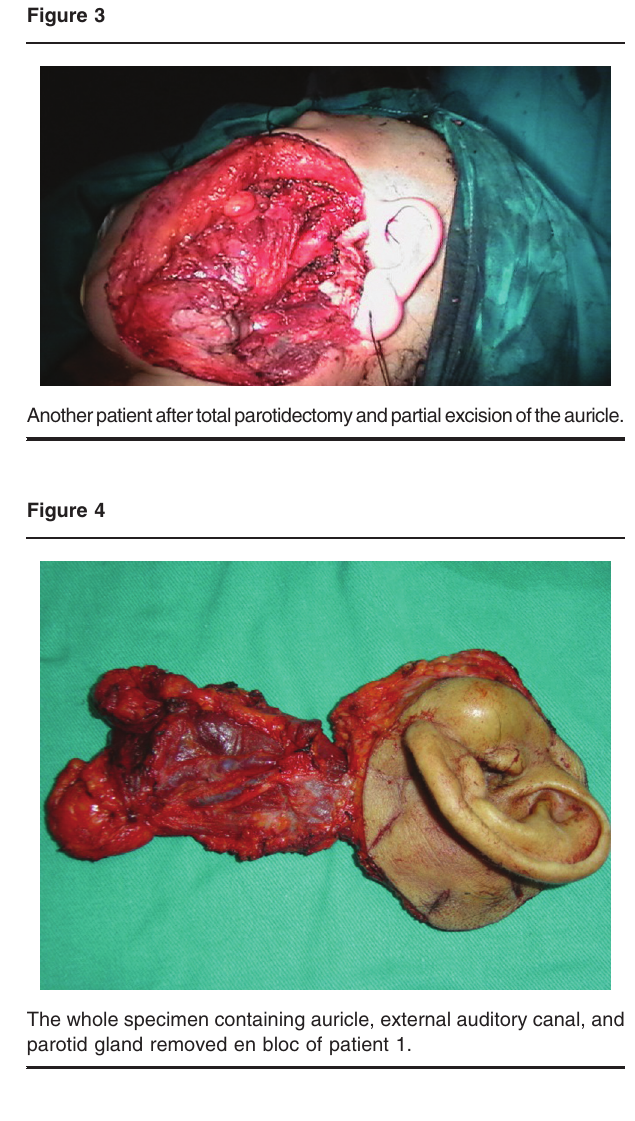
Patient 1 after total parotidectomy, partial mandibulectomy, resection of temporomandibular joint, and partial temporal bone resection with partial excision of the auricle.